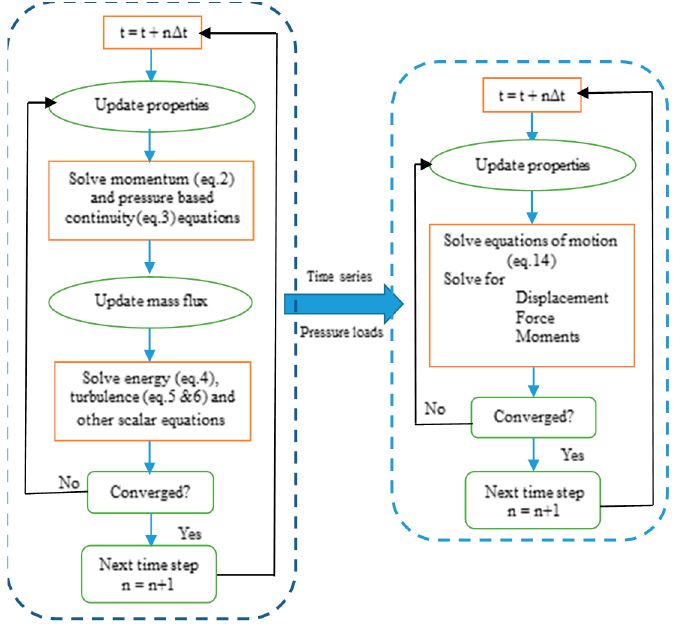
Figure 2. Uni-directional fluid structure coupling algorithm.